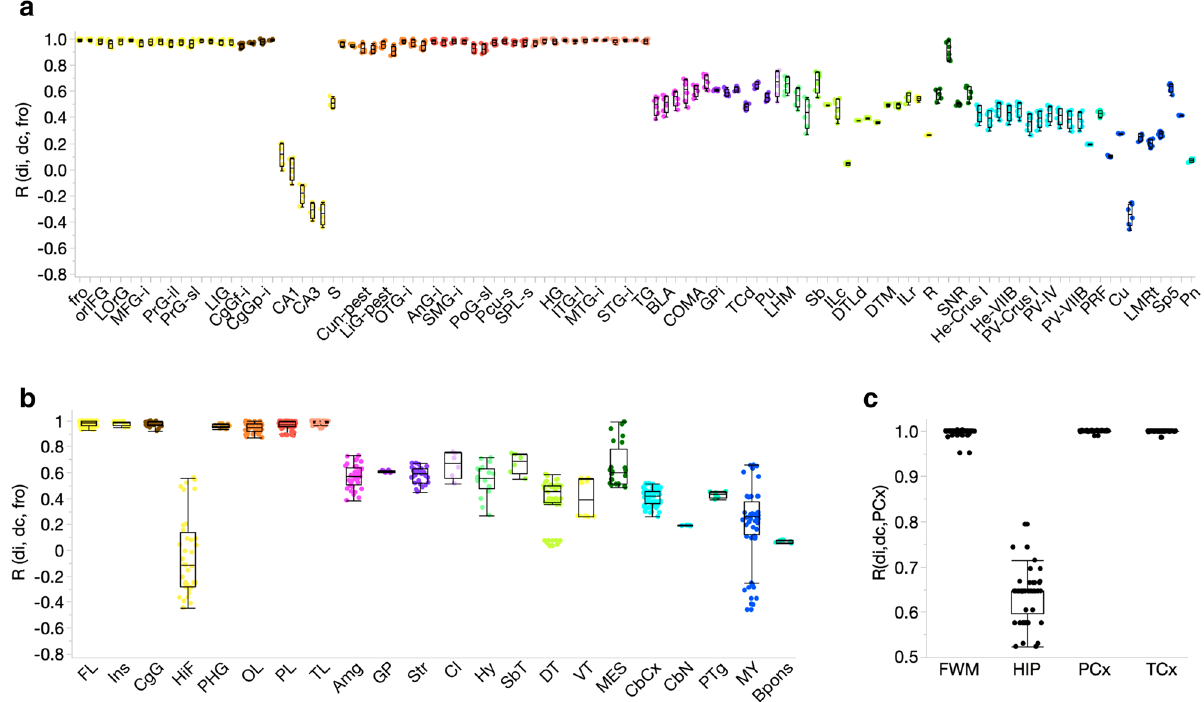
Figure 3. Inter-individual variability across brain regions. ( a ) Euclidian distances of AMPAR subunits per structure (111) per subject (n = 6; d i ) were correlated against a standard (frontal operculum, fro ; d c ) using microarray data corrected by age. Structures are organized in a rostro-caudal order as in Fig. 2. Correlation coefficients (R) closer to one indicate higher similarity in expression patterns between the substructures and the standard. Each point is a single subject containing the collective information of all four AMPAR subunits. ( b ) Same information as in a but grouped by structure. ( c ) Euclidian distances of AMPAR subunits per structure (4) and per subject (n = 50) were correlated against the Parietal Cortex ( PCx ) using ADTBI data corrected by age. The hippocampus ( HIP ) is drastically different from the other three regions and also highly variable between subjects. FWM , forebrain white matter, TCx , Temporal cortex. Each point is a single